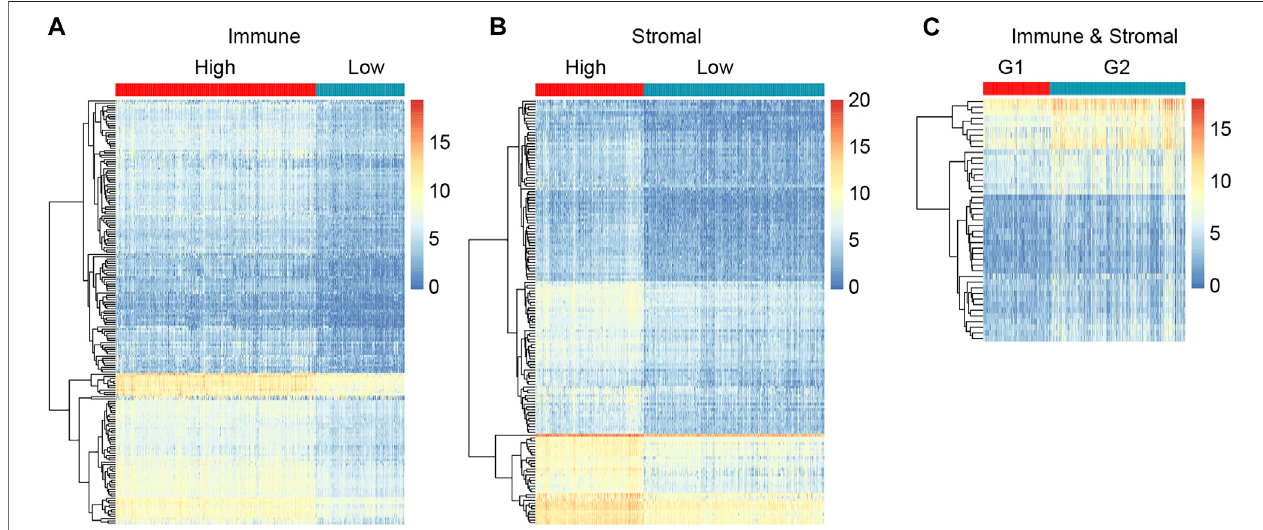
FIGURE 3 | Compare of gene expression pro fi les in different immune/stromal score groups to identify DEGs. (A) Heatmap showing DEGs in high versus low Immune score groups. (B) Heatmap showing DEGs in high versus low Stromal score groups. (C) Heatmap showing DEGs in G1 (high immune score and low stromal score group) versus G2 (low immune and stromal score group, high immune and stromal score group, low immune score and high stromal score